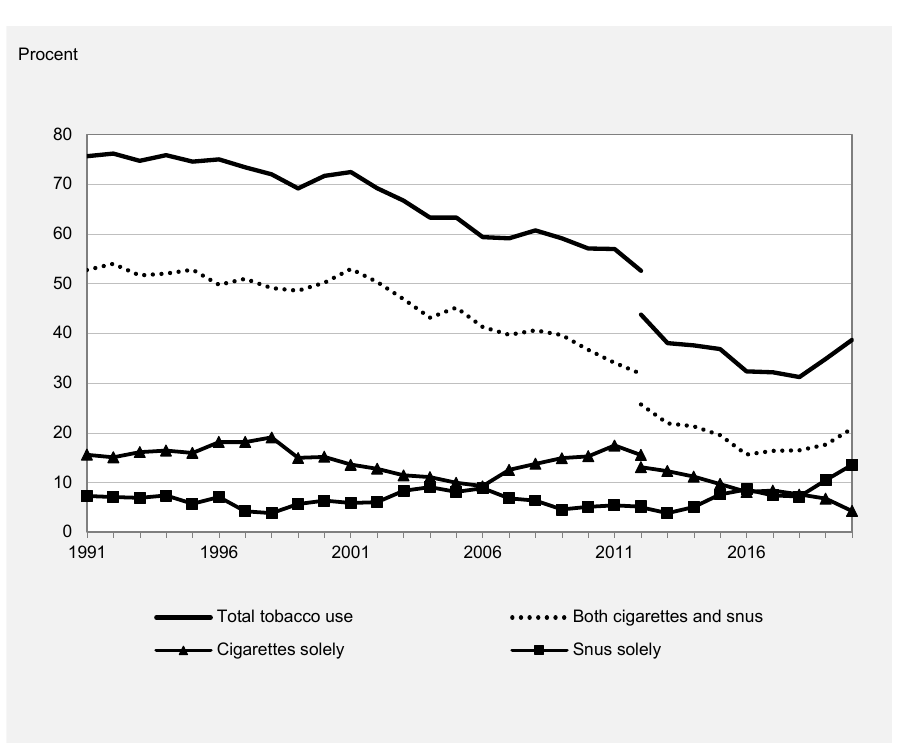
Figure 2. Use of tobacco among 15–16 ‐ year ‐ old males in Sweden, 1991–2020.